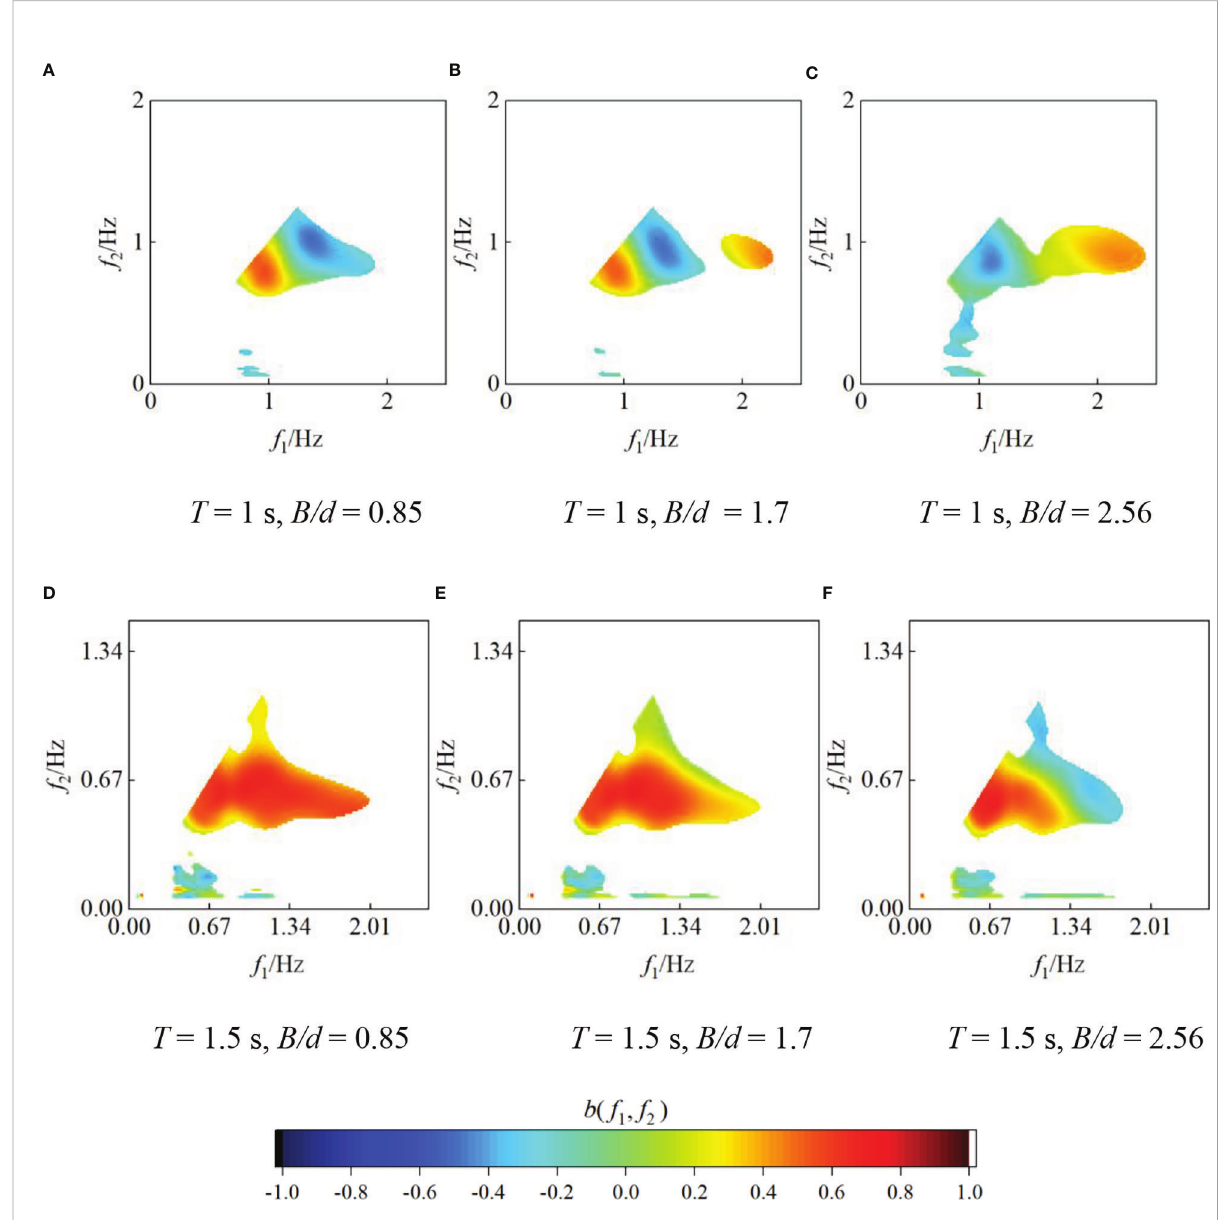
FIGURE 14 Wavelet-based bispectrum variation under different top widths ( H i = 0.043m, D = 0.27m, x = 0.5m) (A) T = 1 s, B/d = 0.85 (B) T = 1 s, B/d = 1.7 (C) T = 1 s, B/d = 2.56 (D) T = 1.5 s, B/d = 0.85 (E) T = 1.5 s, B/d = 1.7 (F) T = 1.5 s, B/d =